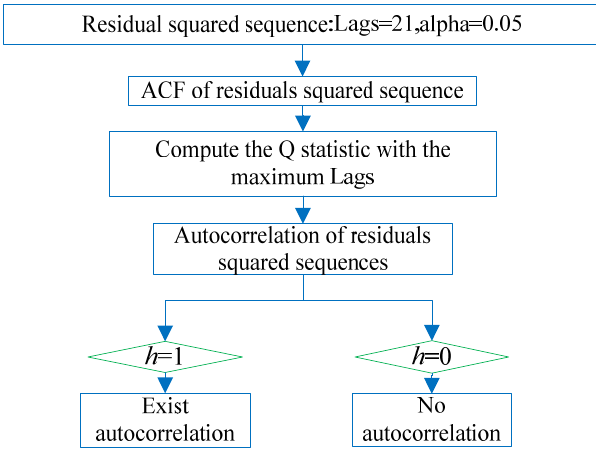
Figure 6. Autocorrelation Q test process.